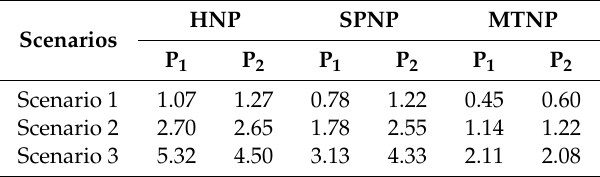
Table 12. Natural Parks´ Consumer Surplus ( € / person) for Scenario and